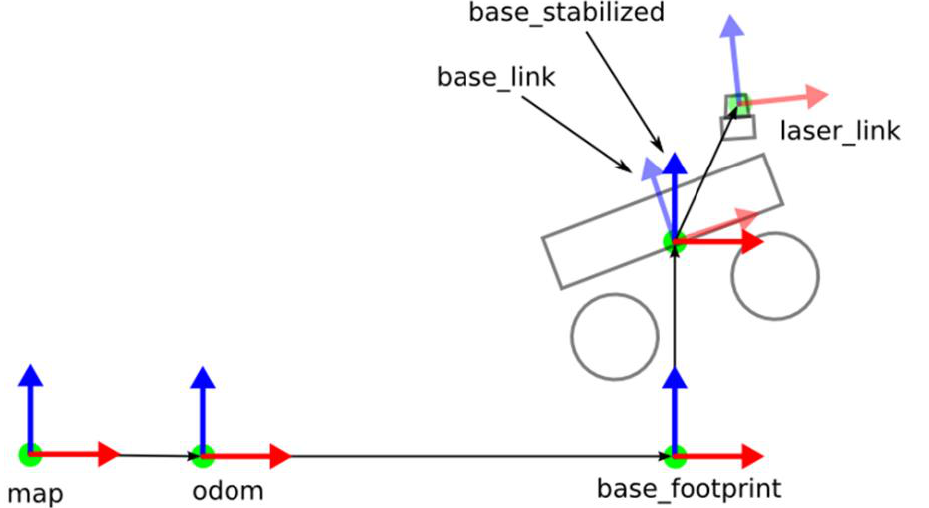
Fig. 4. Frame interaction for mobile